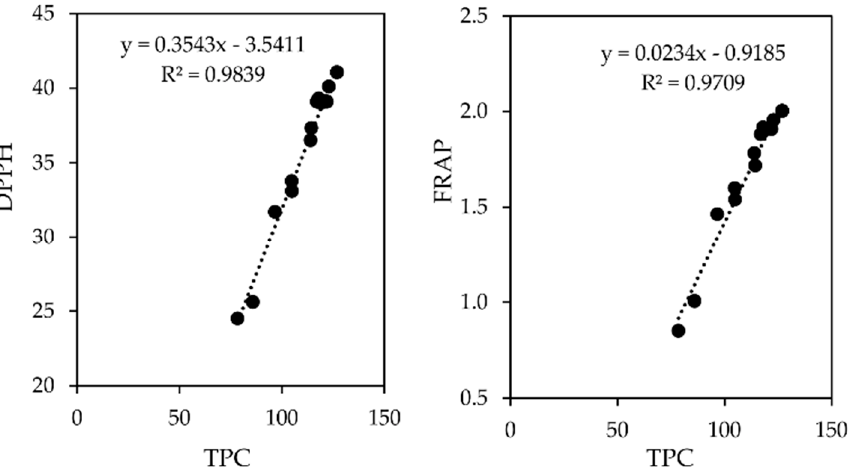
Figure 5. Correlations between AOA measured by DPPH and FRAP methods (TEAC mmol Trolox 100 g − 1 ) with TPC (mg GAE 100 g − 1 ). For both correlations, all data of the study (all sample types and all days of storage) were used.